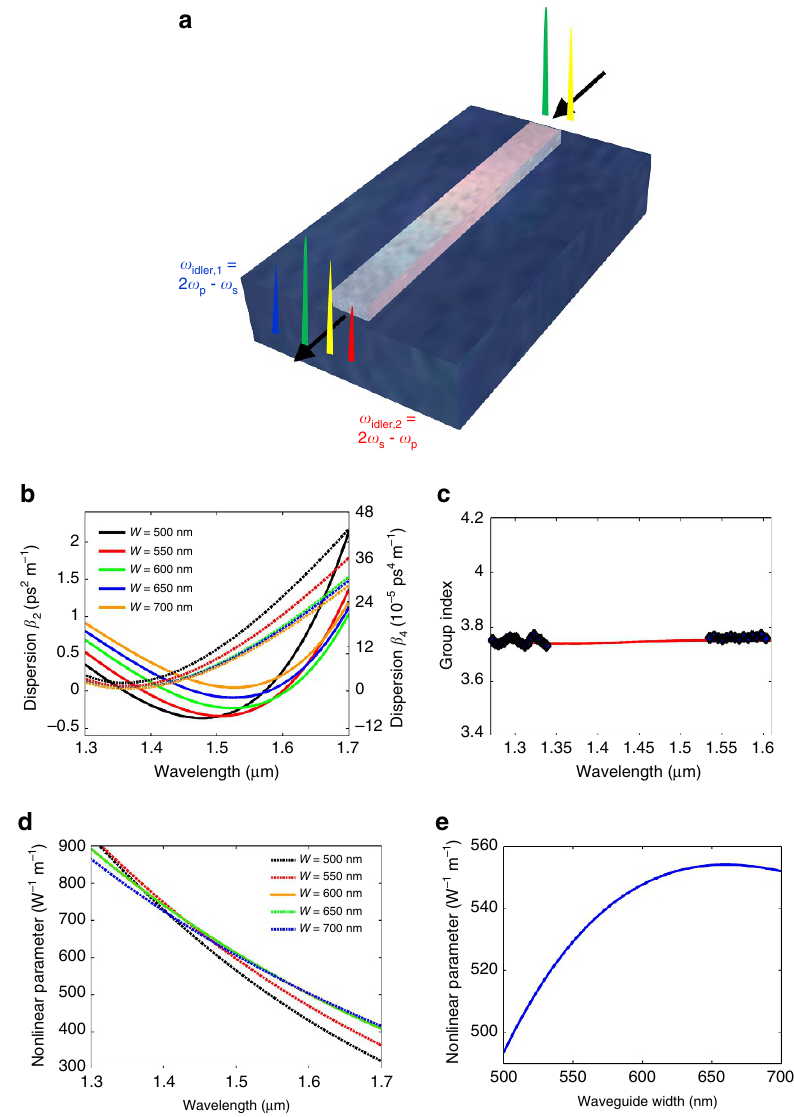
Figure 2 | Device schematic and optical properties of the USRN waveguides. ( a ) Schematic of the ultra-silicon-rich nitride waveguides used to perform four-wave-mixing experiments. ( b ) The calculated second-order ( b 2 , solid lines) and fourth-order ( b 4 , dashed lines) dispersion of the USRN waveguides for different waveguide widths ( W ). The USRN waveguide height is fixed at 300nm. ( c ) Measured and calculated group index of the fabricated USRN waveguide. ( d ) Calculations of the nonlinear parameter of the waveguide as a function of wavelength for various waveguide widths (W) and fixed waveguide height of 300nm. ( e ) Nonlinear parameter as a function of waveguide width for a pump at 1,550nm. The values of the measured n , k values of the USRN films are used in the dispersion and nonlinear parameter